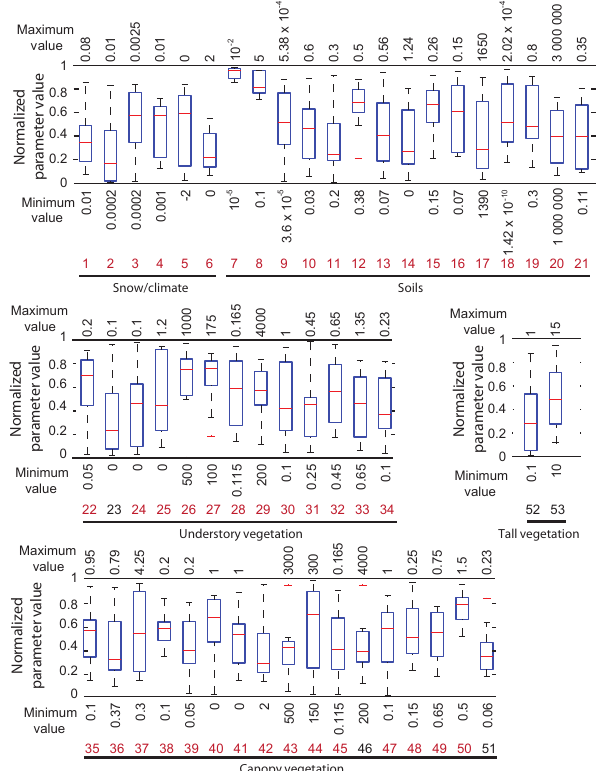
Figure 7. Plots of model-predicted streamflow at the outlets for middle Stringer Creek, Stringer Creek (calibration site), and Ten- derfoot Creek alongside predictions and observations of snow water equivalent at the Onion Park and Stringer Creek SNOTEL sites that satisfy all hierarchically applied constraints. Each grey line corre- sponds to the simulation from one of nine behavioral parameter sets.